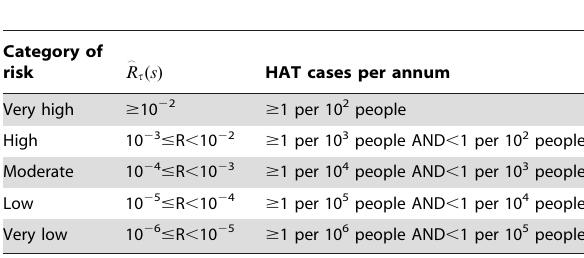
Table 1. Thresholds for the definition of sleeping sickness risk categories.